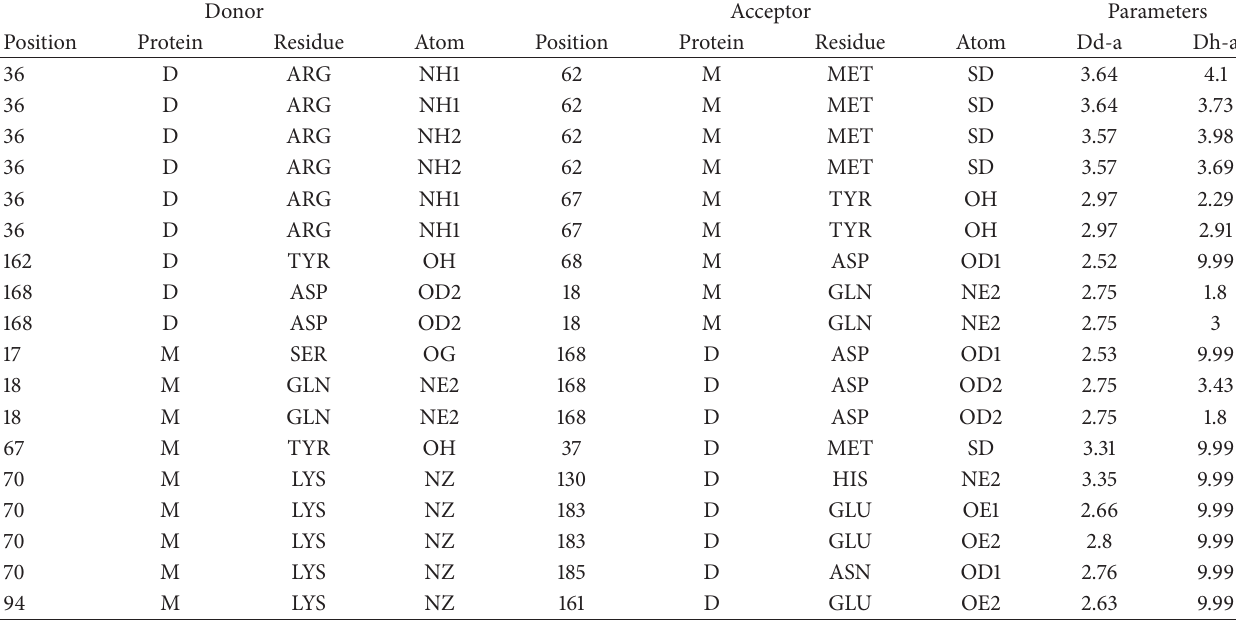
Table2:Sidechain-sidechainhydrogenbondinteractionsinthefinalsimulatedandrefinedMDM2-DHFRproteincomplexin Homosapiens .